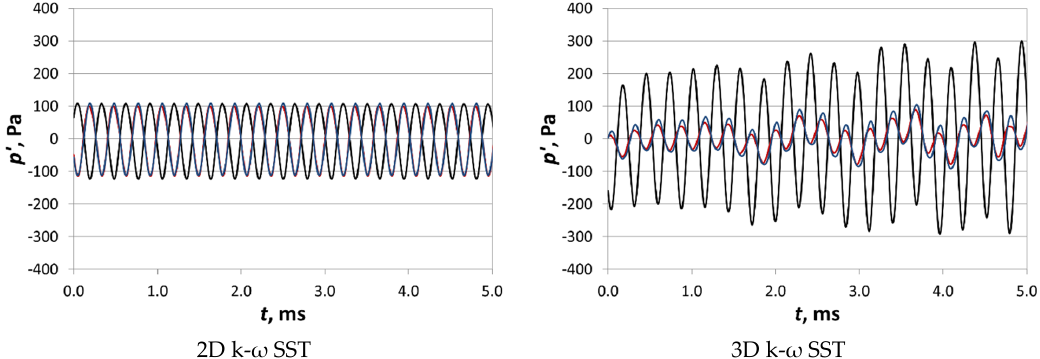
Figure 18. Acoustic pressure fluctuations for the main flow channel velocity equal to 70 m/s—CFD.